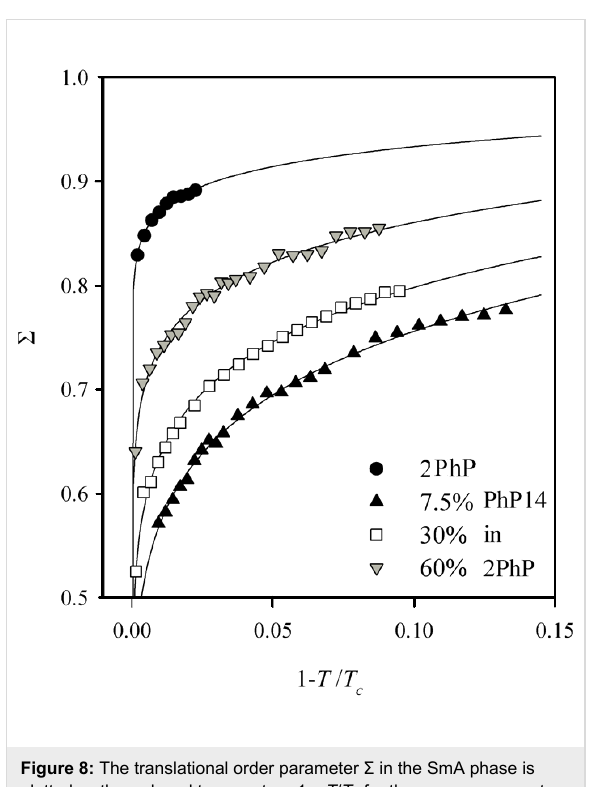
Figure 8: The translational order parameter Σ in the SmA phase is plotted vs the reduced temperature 1 – T / T c for the pure component 2PhP and the mixtures with 7.5%, 30% and 60% PhP14 in 2PhP , respectively. The pure 2PhP shows the highest order parameters of about 0.9. The value of Σ is reduced after the addition of 7.5% of PhP14 to about 0.7 and increases again slowly by the addition of more PhP14 for the mixture with 30% PhP14 until it reaches a value of 0.8 for the 60% mixture.